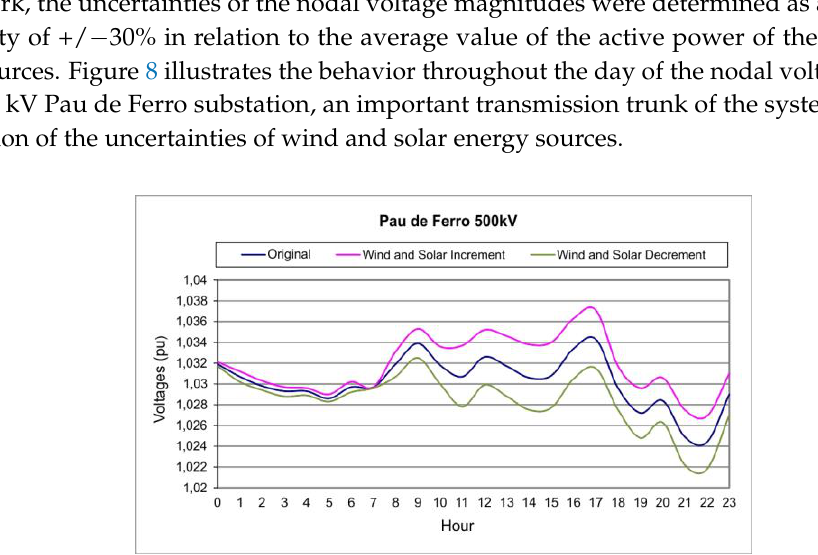
Figure 8. Uncertainties in nodal voltage magnitudes of 500 kV bus of Pau de Ferro substation.